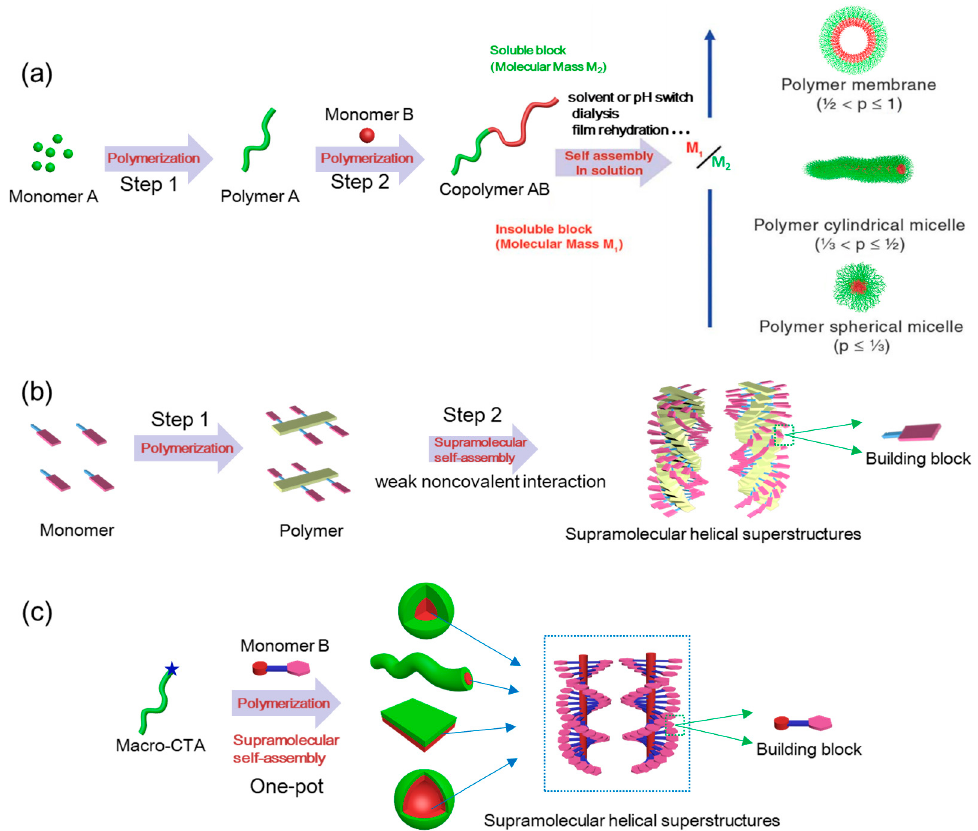
Figure 4. Schematic representation of ( a ) traditional postpolymerization self-assembly, ( b ) previous supramolecular self-assembly in polymer systems and ( c ) in situ supramolecular self-assembly mediated by PISA.